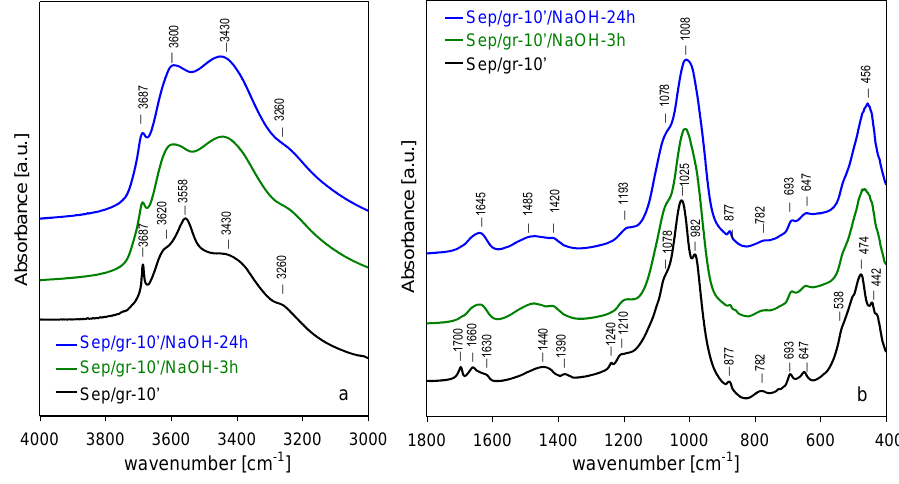
Figure 7. Evolution of FTIR spectra for sepiolite ground for 10 min and treated with NaOH at 90 °C, time effect: ( a ) 3000–4000 cm −1 , ( b ) 400–1800 cm −1 .